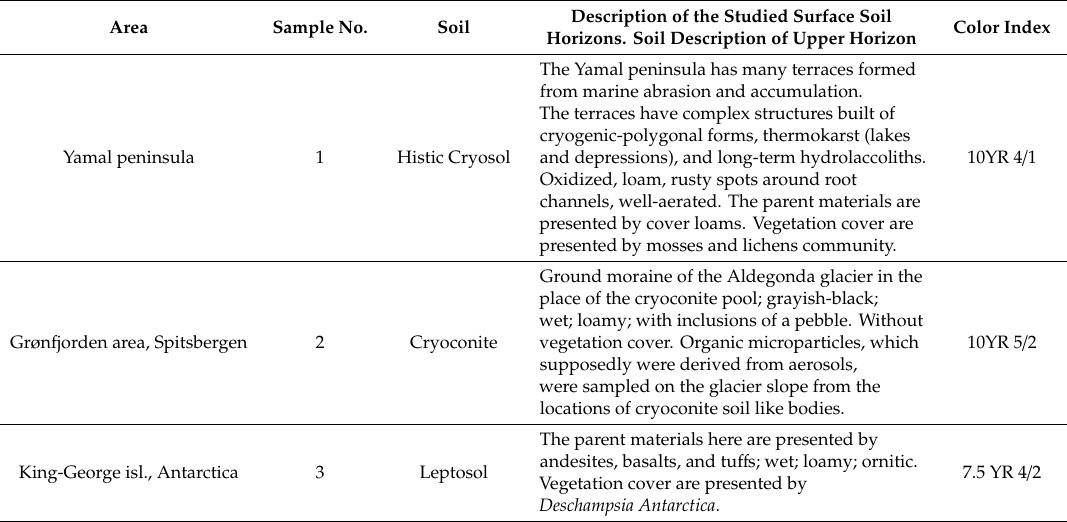
Table 2. Description of the studied surface soil samples.